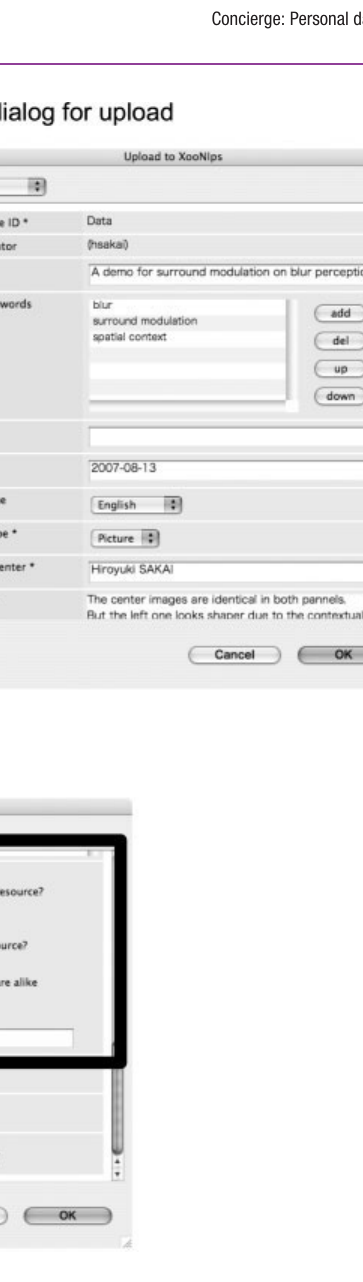
ity (http:/incf.org, Bjaalie and Grillner, 2007). Several databases using window ( Figure 7A ). By selecting each of them, resources tagged with the selected keyword are listed up in the top-right table. Subsequently, by selecting a resource, the metadata are shown in the right-bottom table. Then, the users can download the resources shared in XooNIps and manage them with their metadata entered by the original contributors as “Misc” type